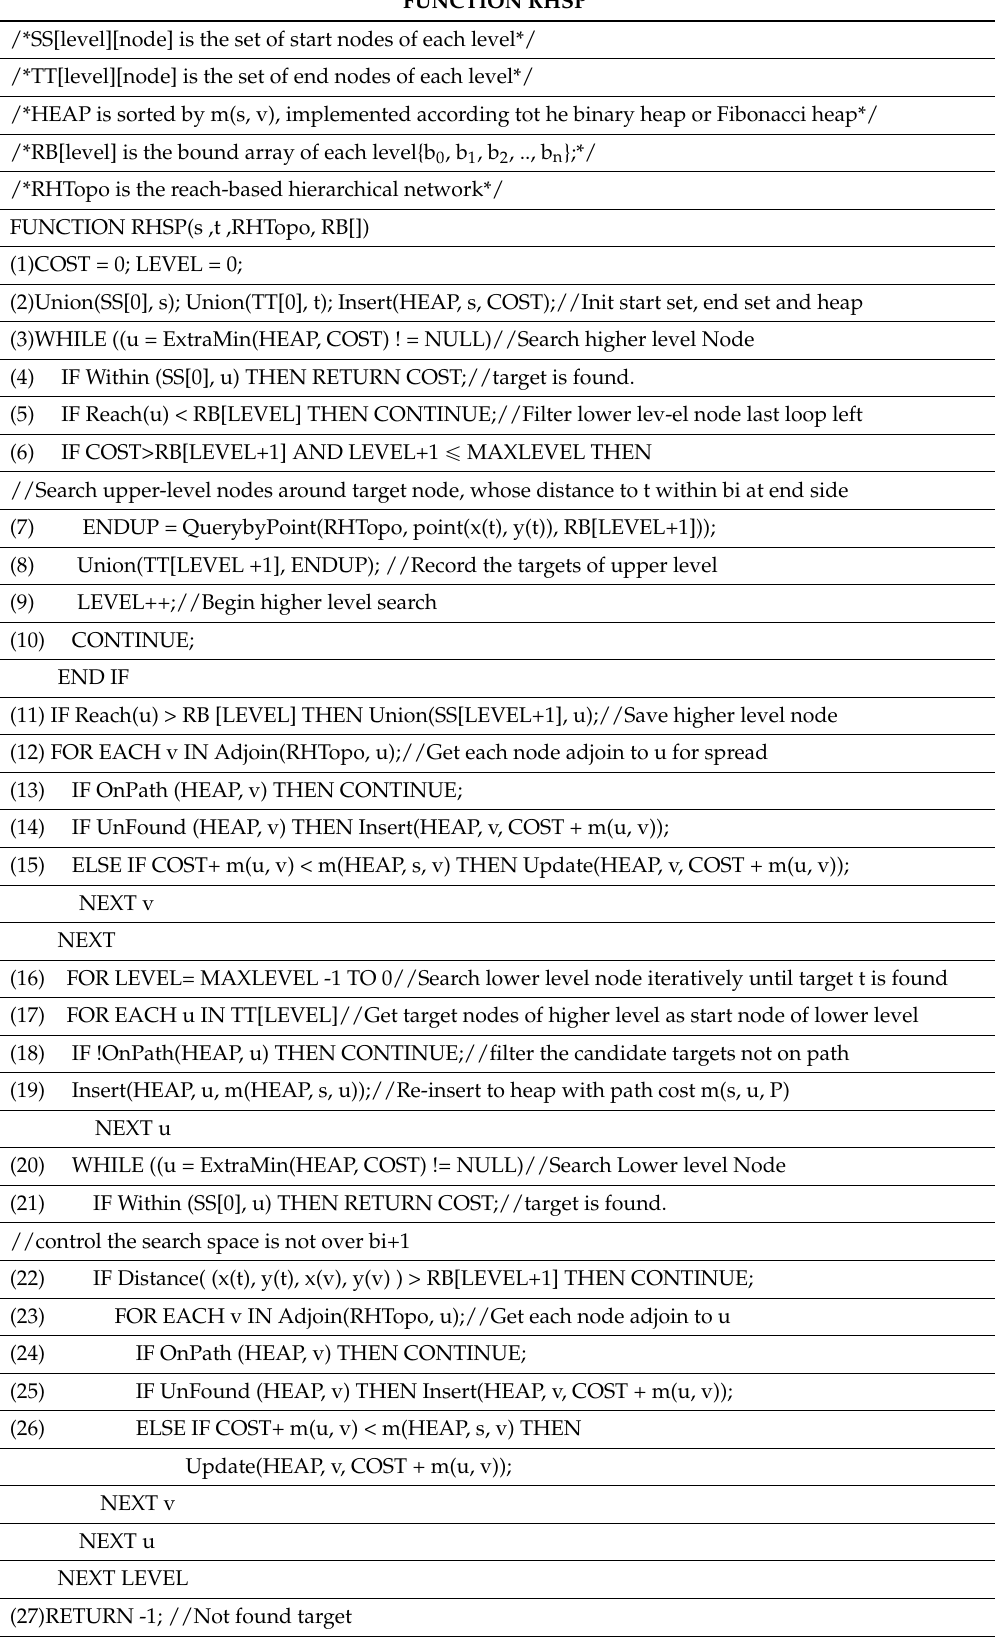
Table 2. The Pseudo Code of the Reach-Based Hierarchical Shortest-Path Algorithm. FUNCTION